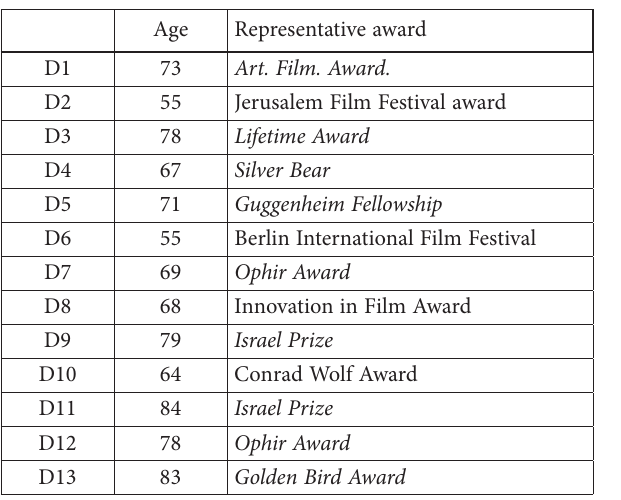
Table 1. Information about the directors: the age of the directors (source: created by